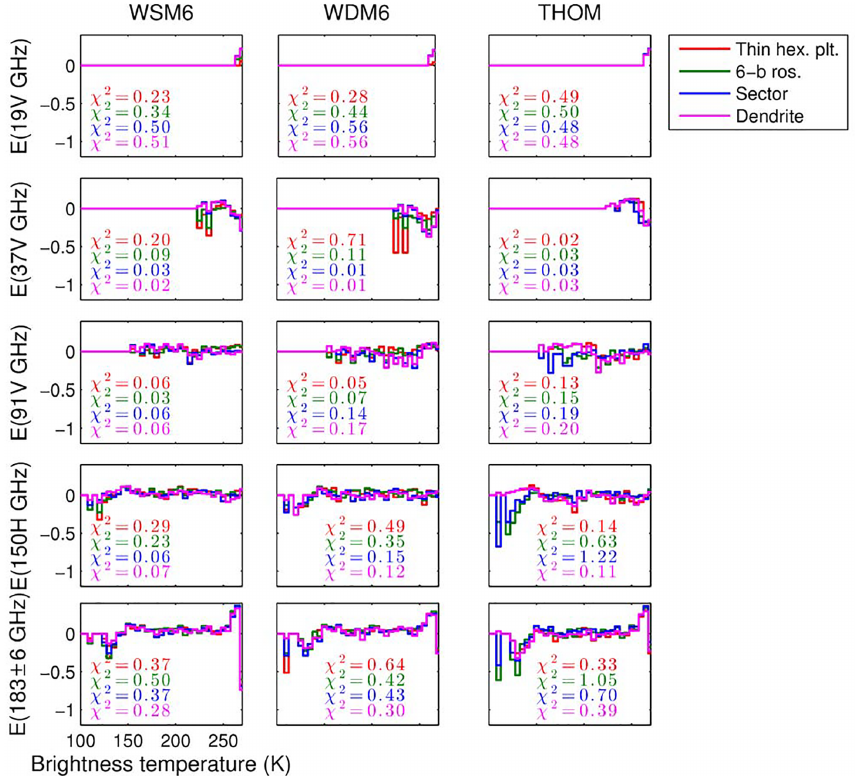
Figure 18. The simulated (solid coloured lines) residuals of the χ 2 test for the simulated SSMI/S 19V, 37V, 91V, 150H and 183 ± 6GHz channels for the MCS events on 13 January 2011 at 22:00UTC. Note that the χ 2 value is included for selected DDA habit simulated distributions calculated from all temperature bins below 270K.